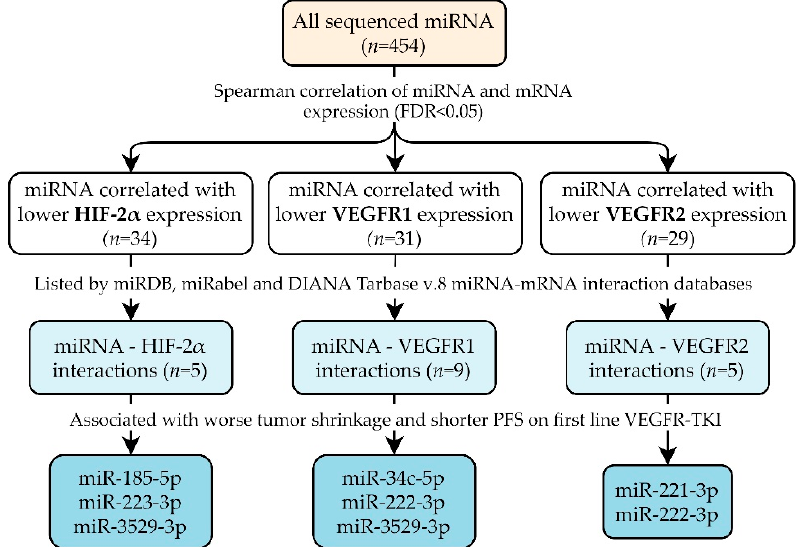
Figure 1. Through correlation analysis and miRNA–mRNA interaction databases, 14 miRNAs were identified. Of these, six were correlated with tumor shrinkage and PFS. Abbreviations: miRNA = microRNA, FDR = false discovery rate, HIF-2 α = hypoxia-induced factor 2 α , VEGFR1 = vascular endothelial growth factor receptor 1; VEGFR2 = vascular endothelial growth factor receptor 2, PFS = progression-free survival, VEGFR-TKI = vascular endothelial growth factor receptor tyrosine kinase inhibitor, miR =